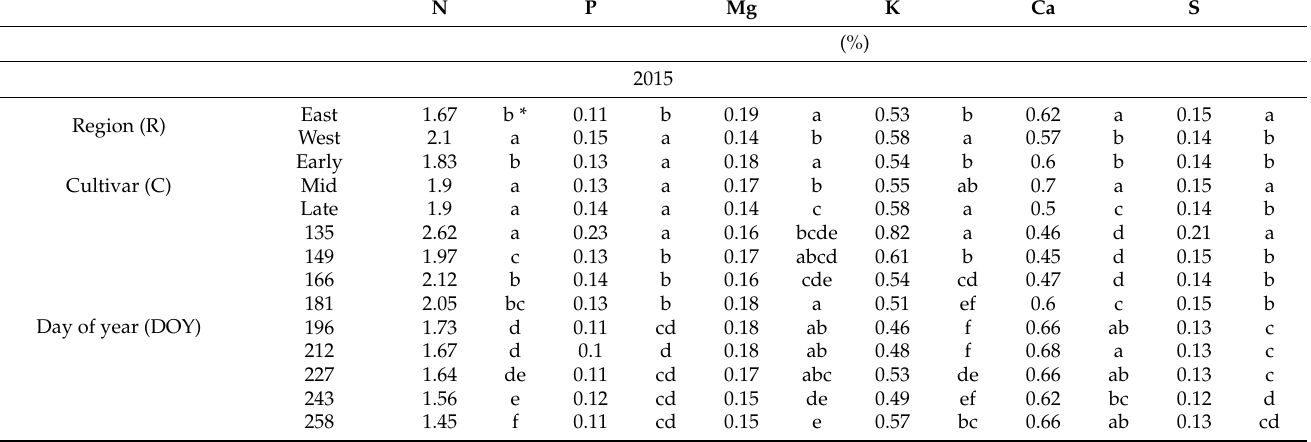
Table 1. The effect of growing region (R), cultivar (C), and day of year (DOY) on the concentration of tissue macronutrients in recently expanded leaves of early, mid-, and late-season cultivars of northern highbush blueberry in eastern and western Washington. ‘Duke’ was the early-season cultivar, ‘Draper’ the mid-season cultivar, and ‘Aurora’ and ‘Liberty’ the late-season cultivars in eastern Washington and western Washington, respectively. Non-significant interactions are highlighted with bold